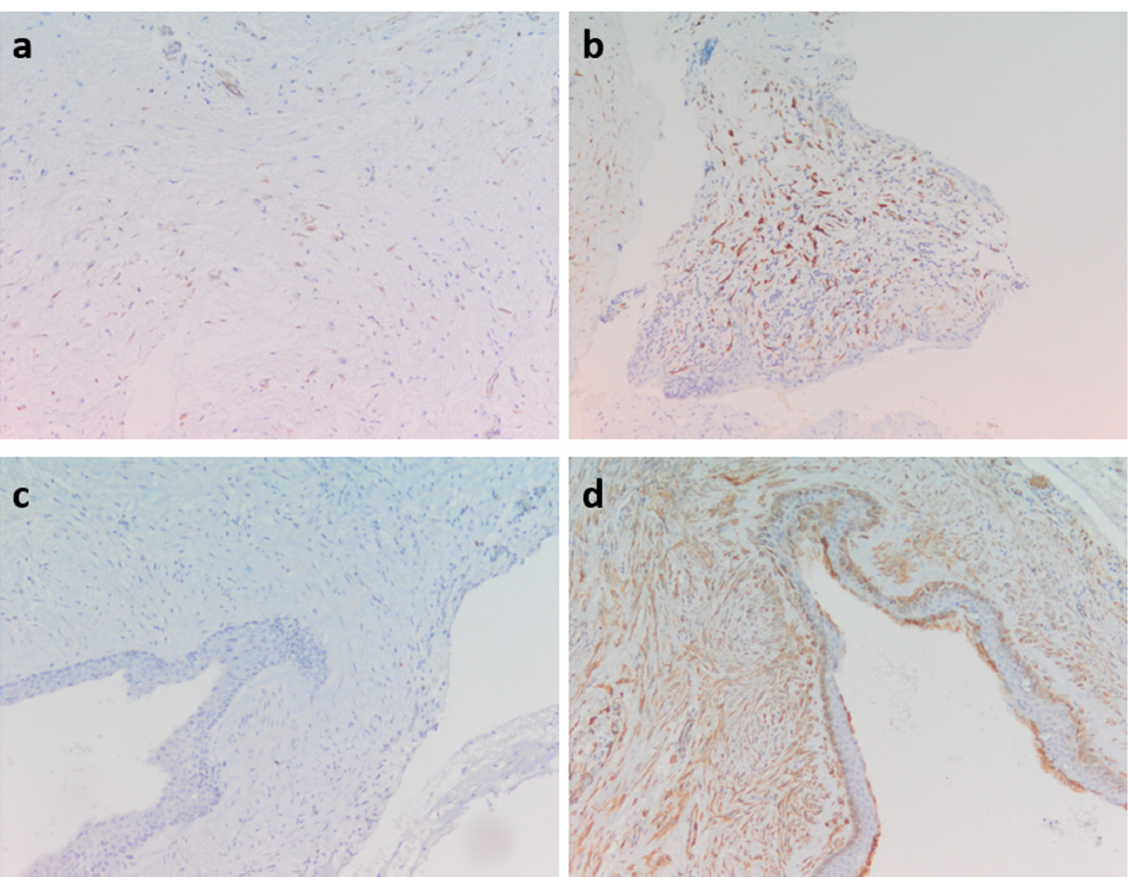
Figure 4. ( a ), NBCCS-OKC, moderate desmin expression around the vessels, ×10; ( b ), Solitary OKC, caldesmon scattered expression, ×10; ( c ), Sporadic OKC, focal desmin expression, ×10; ( d ), NBCCS- OKC, caldesmon in plump fibroblasts in the epithelium and throughout the connective wall,